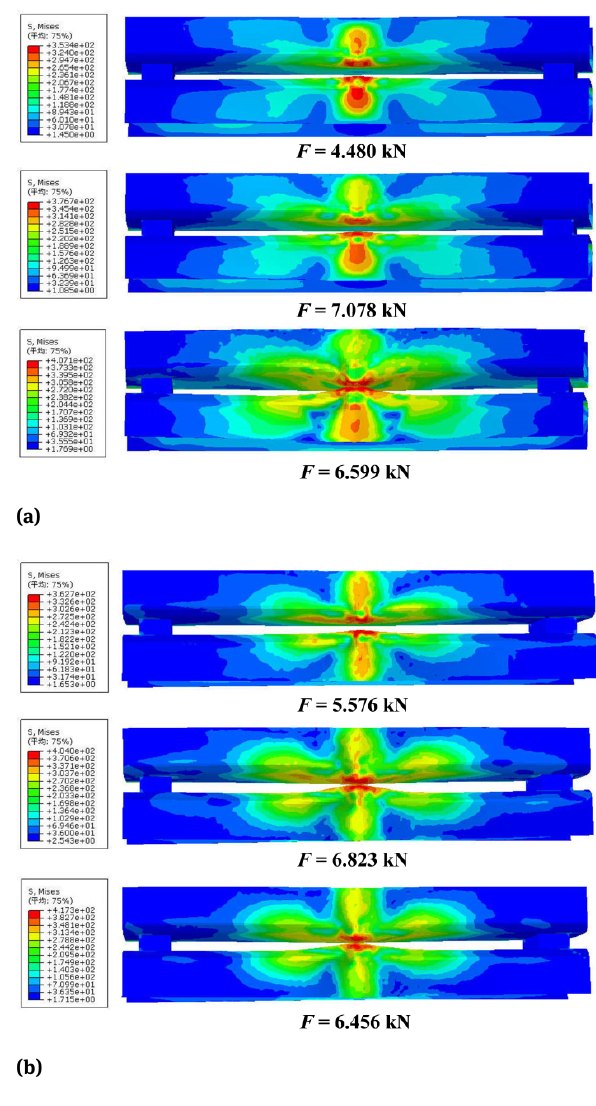
Figure 11: Stress and deformation evolution in outer aluminum sheet of double-channel CARALL beams: (a) SHCXL-A and (b) SHCXL-